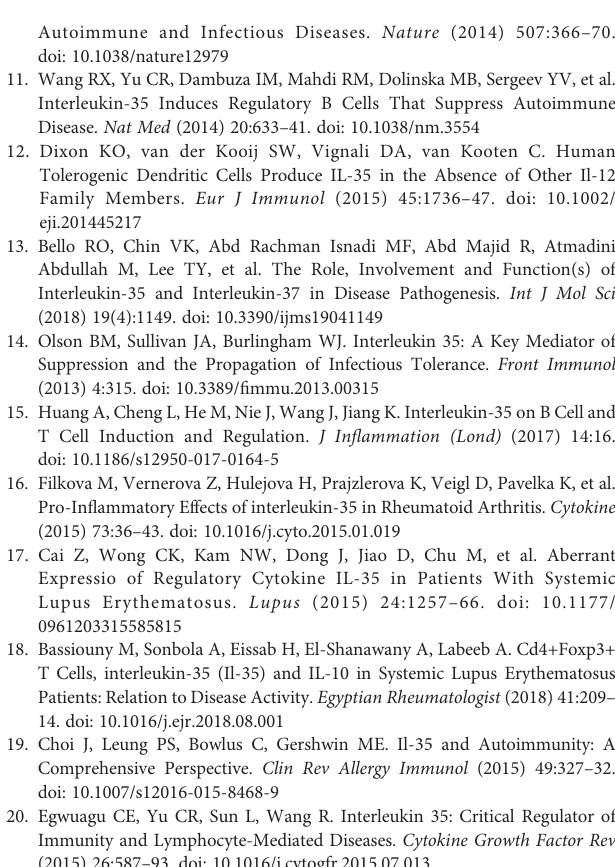
Supplementary Figure 1 | Comparison of lymphocyte subpopulations expressing surface IL-12R b 2 or gp130 (in percentage) in controls (n=50) vs SLE patients (n=50). (A) The proportion of surface IL-12R b 2 + (left) or gp130 + (right) on CD3 ─ CD4 ─ non-T cells. (B) The proportion of surface IL-12R b 2 + (left) or gp130 + (right) on CD3 + CD4 ─ T cells. (C) The proportion of surface IL-12R b 2 + (left) or gp130 + (right) on CD3 + CD4 + T cells. (D) The proportion of surface gp130 + IL- 12R b 2 + (left) or gp130 + IL-12R b 2 ─ (right) on CD3 + CD4 + T cells. The three lines within each violin plot represent fi rst quartile (bottom line), median (center line) and third quartile (topline). Thesuperscriptaorblabel adjacentto each p -valuedenotes Mann-Whitney U test or unpaired t-test, respectively. Supplementary Figure 2 | IL6ST expression levels in publicly-available RNA-seq datasets as annotated by Human Protein Atlas (HPA). (A) IL6ST expression levels by RNA-seq according to HPA ’ s Consensus Dataset that represents combination of three transcriptomics datasets (HPA, GTEx and FANTOM5). (B, C) IL6ST expression levels by RNA-seq according to Schmiedel et al., 2018 (B) and Monaco et al., 2019 (C) datasets as annotated by HPA. NX: Normalized eXpression; TPM: Transcripts per million;pTPM:TPMvaluespersamplescaledtoasumof1millionTPM.Imageobtained from Human Protein Atlas (available from v20.proteinatlas.org). Supplementary Figure 3 | Correlation of serum IL-35 concentration (pg/ml) with the proportion of CD3 + CD4 + gp130 + (A) , CD3 + CD4 ─ gp130 + (B) , CD3 + CD4 + IL- 12R b 2 + (C) , or CD3 + CD4 ─ IL-12R b 2 + (D)